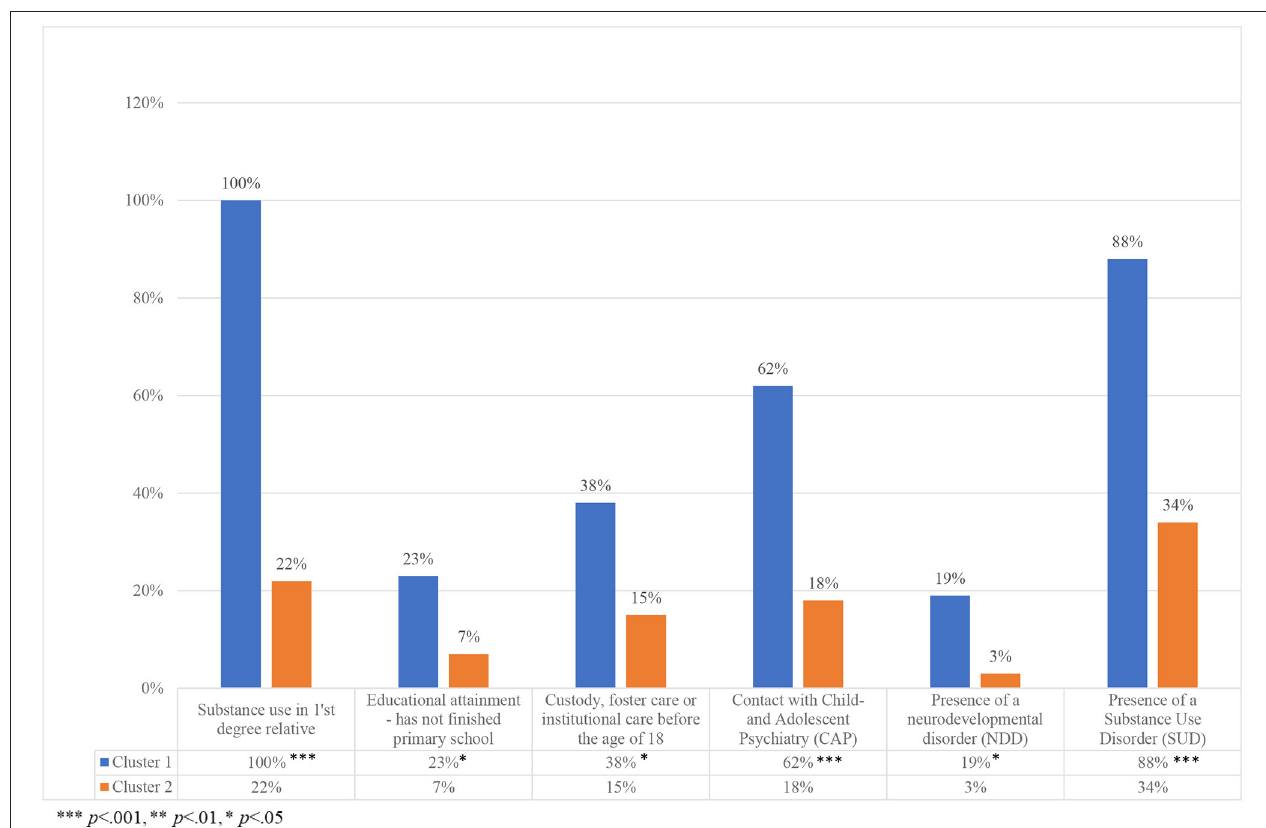
FIGURE 1 | Variables in the cluster analyses.